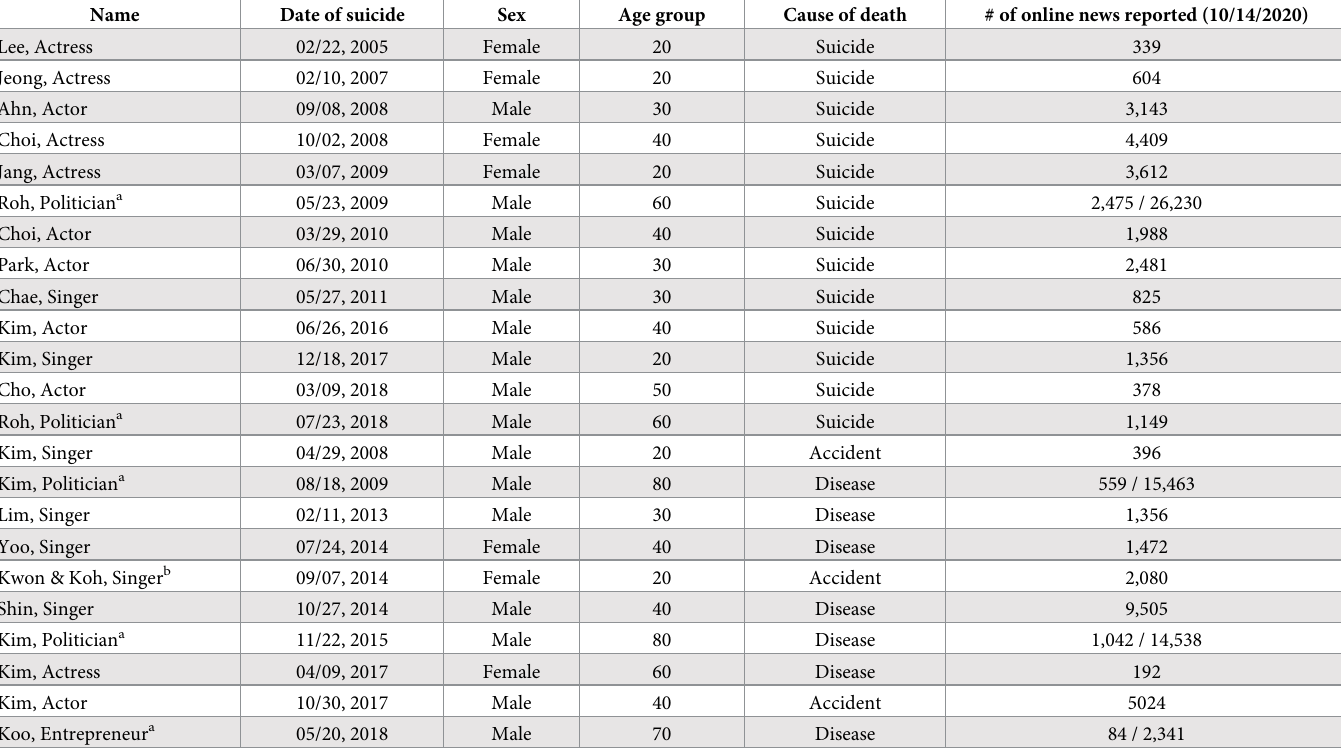
Table 2. Characteristics of celebrity death incidents: